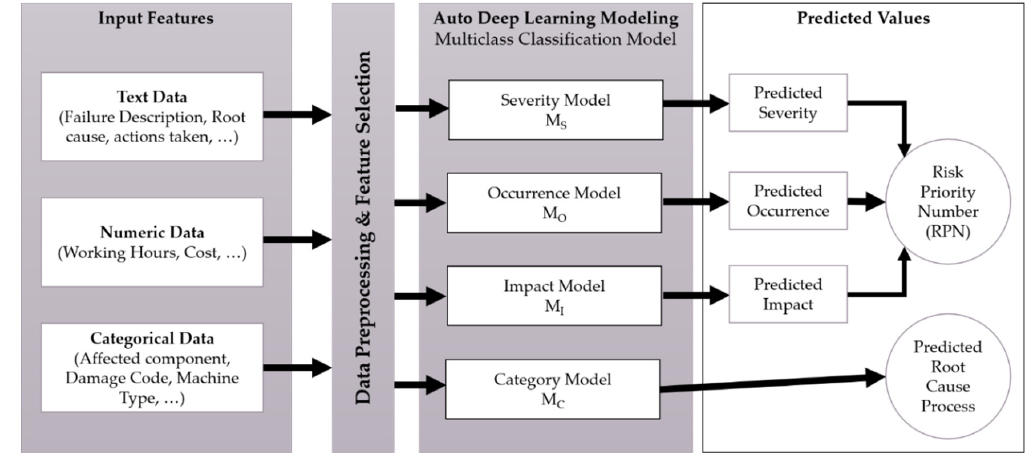
Figure 5. Development of machine learning model.